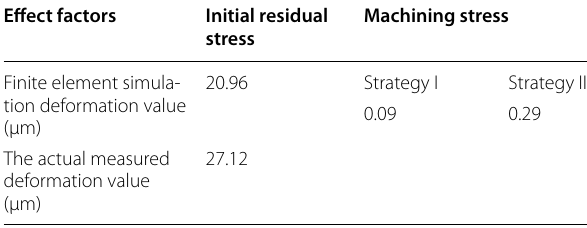
Table 4 Experiment conditions